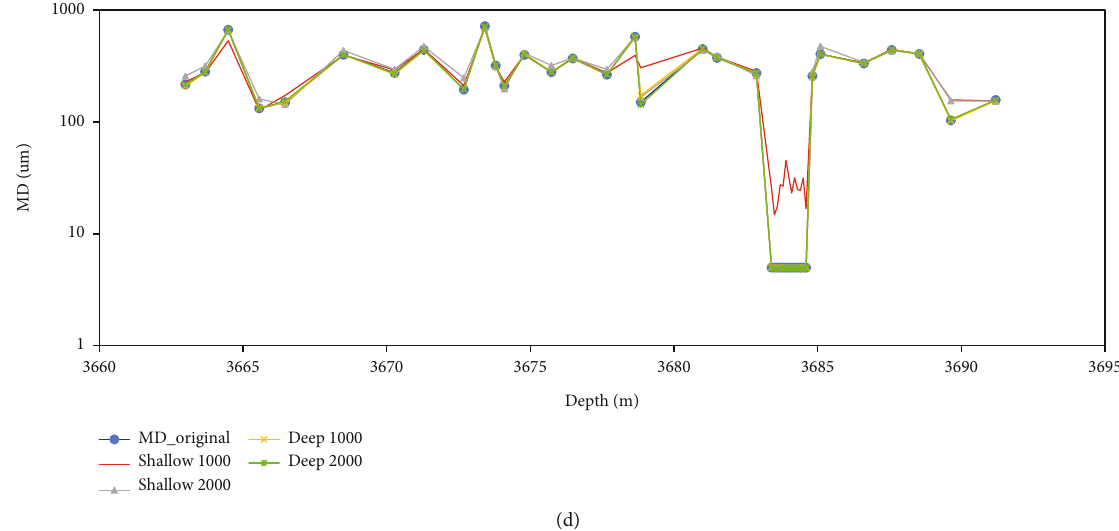
Figure 8: Comparison of training results of MD machine learning methods for well